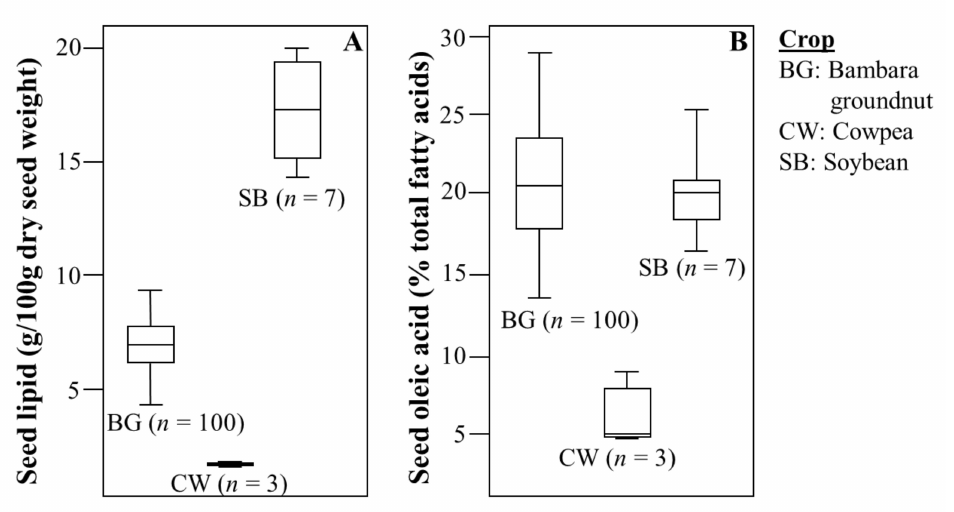
Figure 2. Box-whisker plots indicating ( A ) range of variation for seed lipid concentration and ( B ) seed oleic acid concentration (18:0, n-9) in the global diversity set of 100 bambara groundnut (BG) lines and in representative lines of two other grain legumes: cowpea (CW; n = 3), and soybean (SB; n = 7). For each crop, number of lines ( n ) analysed is indicated below each corresponding box whisker. Y axes: ( A ) seed lipid expressed as g/100 g seed dry weight and ( B ) seed oleic acid expressed as % of total fatty